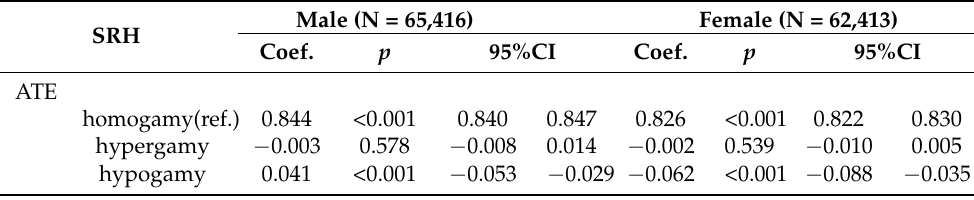
Table 7. Gender heterogeneity in impacts of educational assortative mating on SRH. Male (N = 65,416) Female (N = 62,413) SRH Coef. p 95%CI Coef. ATE homogamy(ref.)